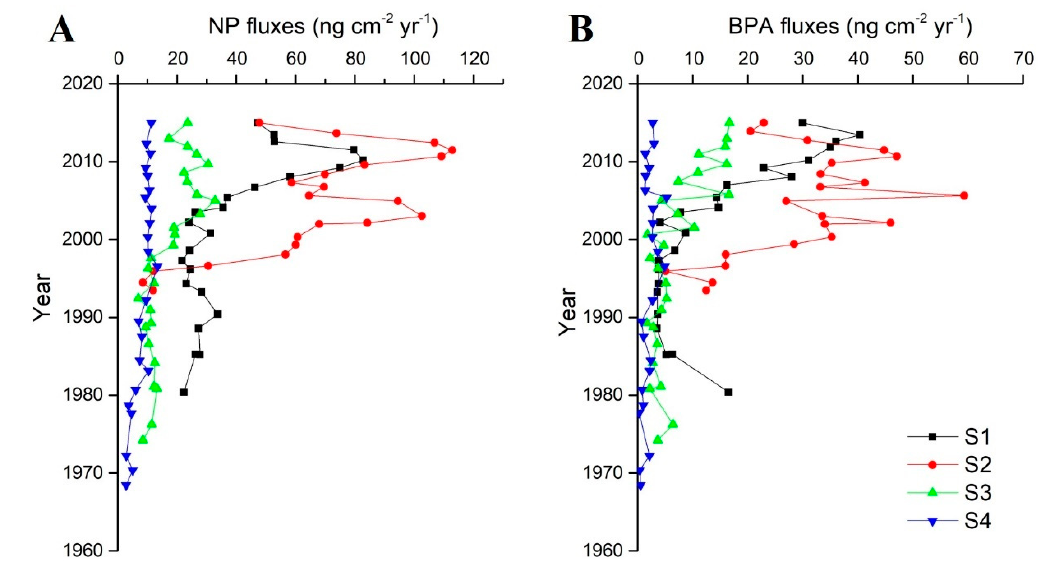
Figure 5. Fluxes of NP and BPA in the study areas. S1-4 present the sampling sites in Figure 1. Table 3. The main features of the sedimentary records of the fluxes of